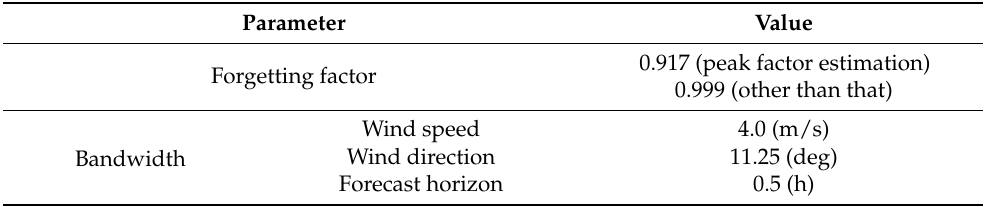
Figure 3. An aerial photograph ( a ) and elevation contours ( b ) around the target point. The non-parametric regressions for each model were carried out under the conditions listed in Table 3. The forgetting factor λ was set to 0.999 in the models other than the peak factor forecast model. The effective number of data in Equation (14) corresponds to approximately 20 days, i.e., the models are always trained by using the past 20 days of data, approximately. On the other hand, 0.917 was used for estimating the peak factor, which corresponds to about 5.5 h. When performing non-parametric regression, it is necessary to set the initial values of the local wind speed conversion and the wind speed correction functions. In this study, a forecast was performed in advance from 1 December to 31 December 2013, prior to the analysis period, and the initial values of each model were obtained by training. Table 3. Summary of model